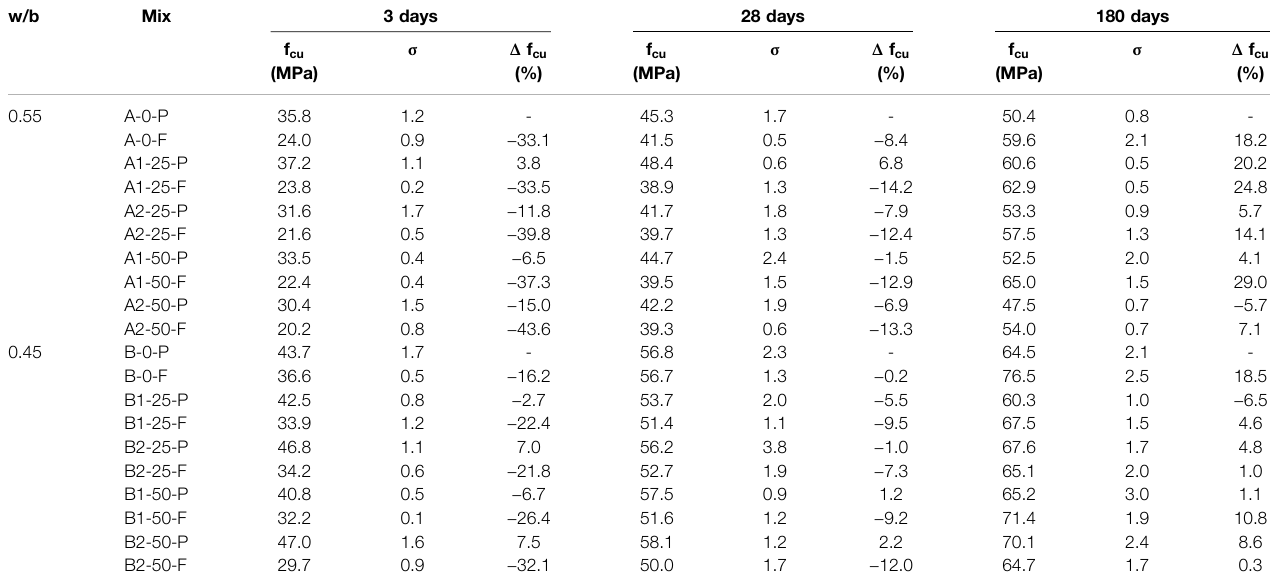
TABLE 6 | Compressive strength